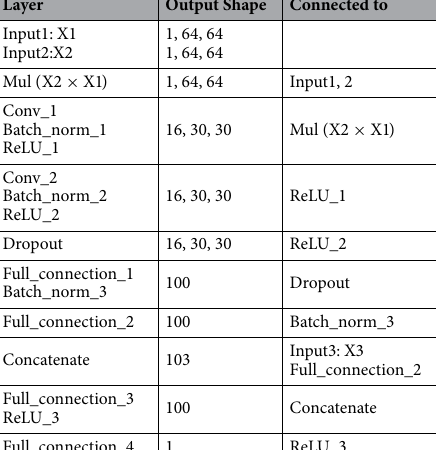
Layer Output Shape Connected